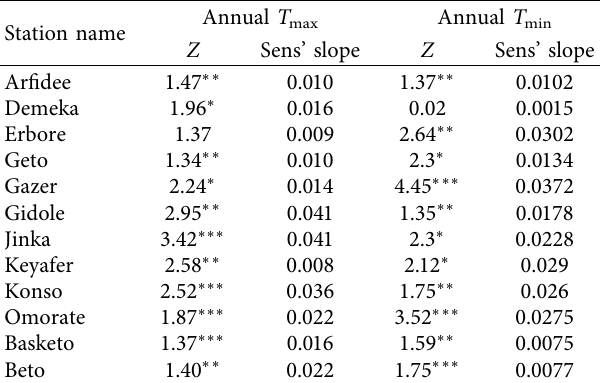
Figure 6: Perceived impacts of climate change by respondent farmers (%) in Southwest